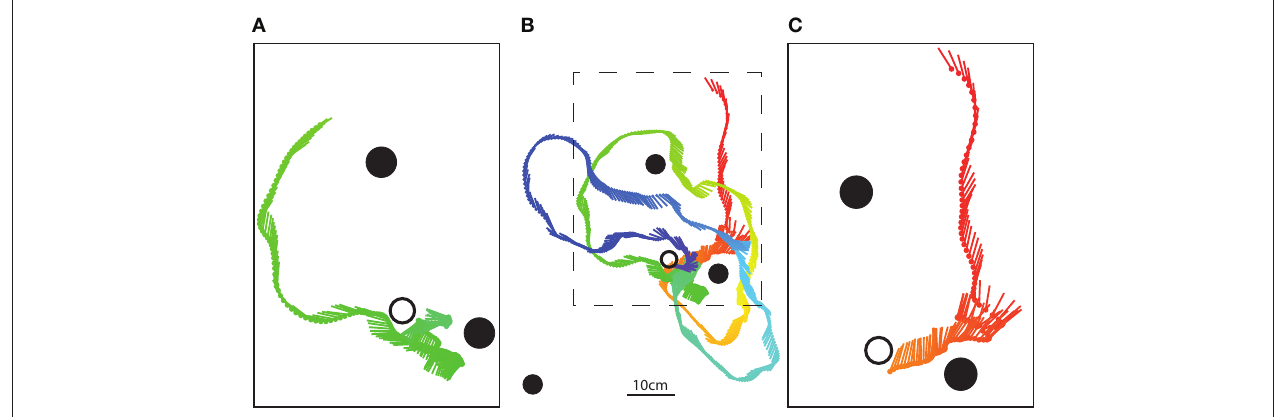
The position of the bee is indicated by circles at 16 ms intervals with lines indicating the orientation of the long axis of the bee; the color ranges from red– yellow–green–blue to illustrate the time course. (A,C) Show magnified parts of this search flight, which consist of landmark fixation, turning, and sideways flight maneuvers, which are often observed